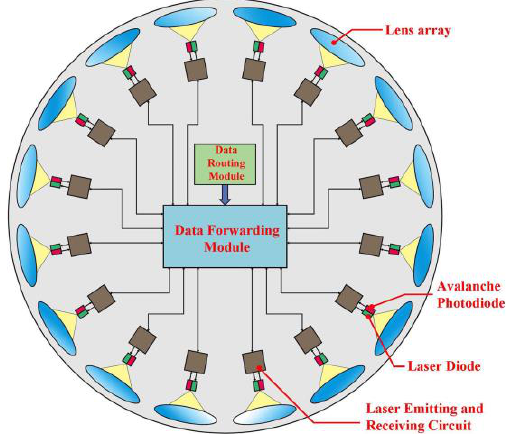
Figure 5. Internal structure diagram of the laser relay station.